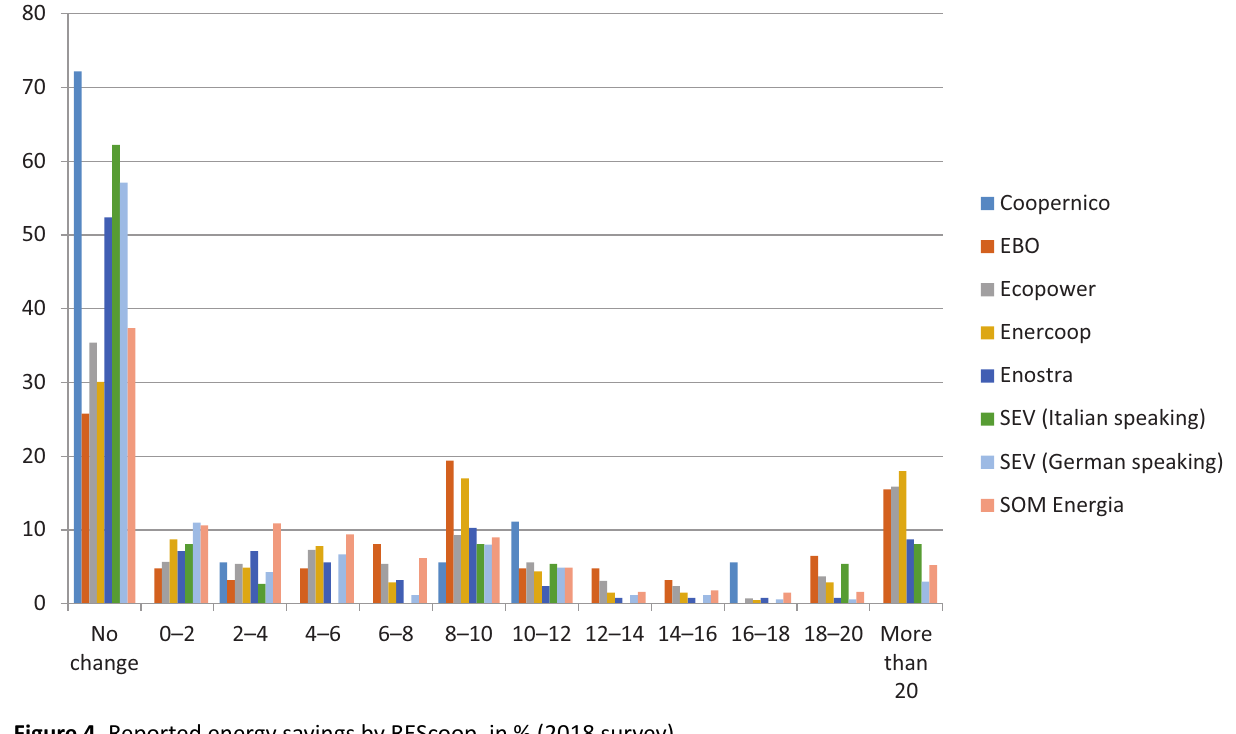
Figure 4. Reported energy savings by REScoop, in % (2018